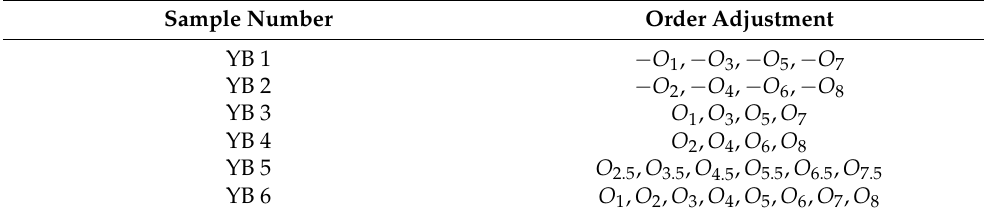
Table 2. Order regulation